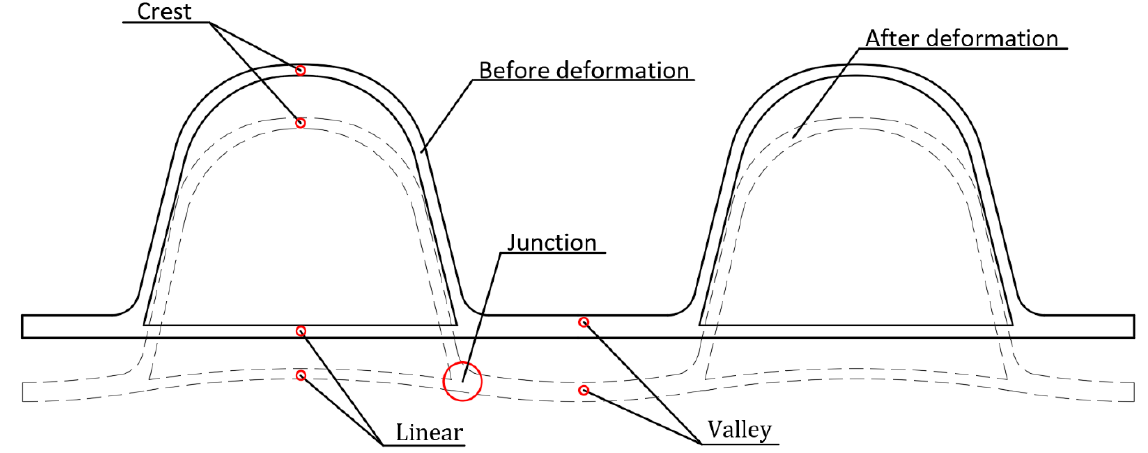
Figure 16. Vertical compression of pipes.